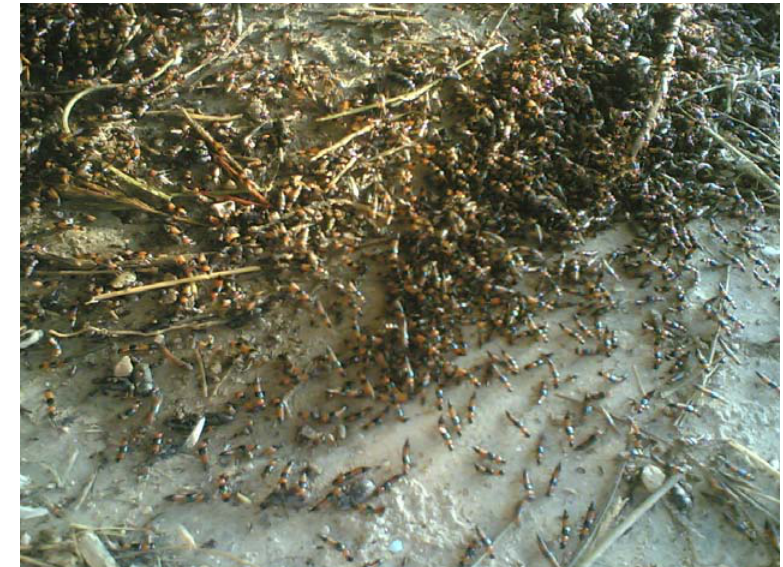
Figure 12. Hibernating Paederus beetles under